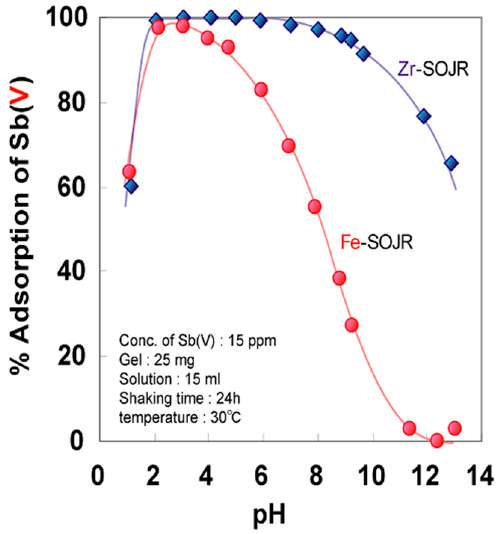
Figure 27. Effect of the equilibrium pH on Sb(V) adsorption by Fe(III)- and Zr(IV)-loaded SOJR [27]. (With permission for reuse from Elsevier B.V.).